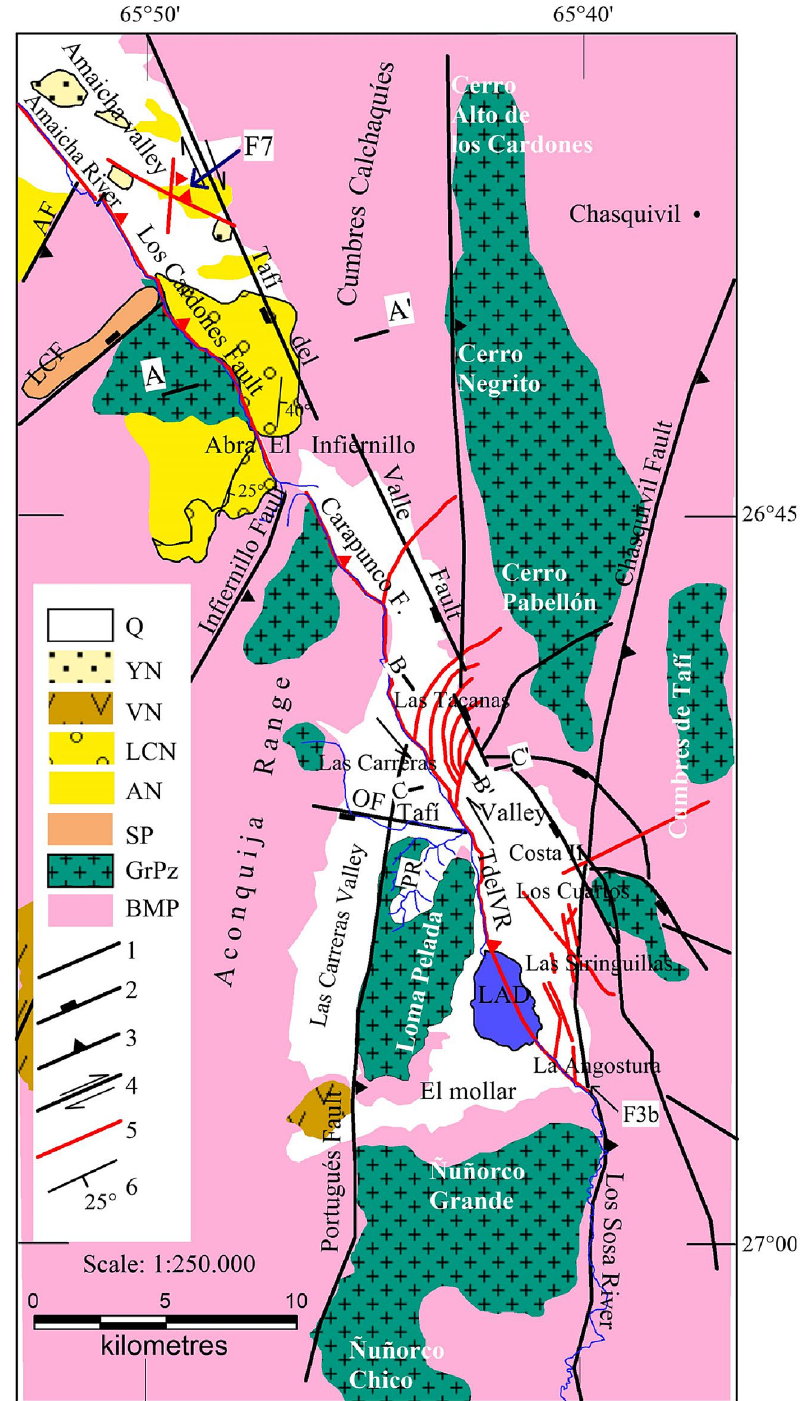
no faults or folds had been recorded in these valleys.